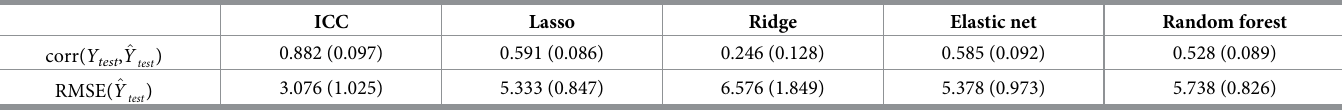
Table 2. Prediction results of different methods for the illustrative example, where corr( Y test , ^ Y datasets with the standard deviation given in the